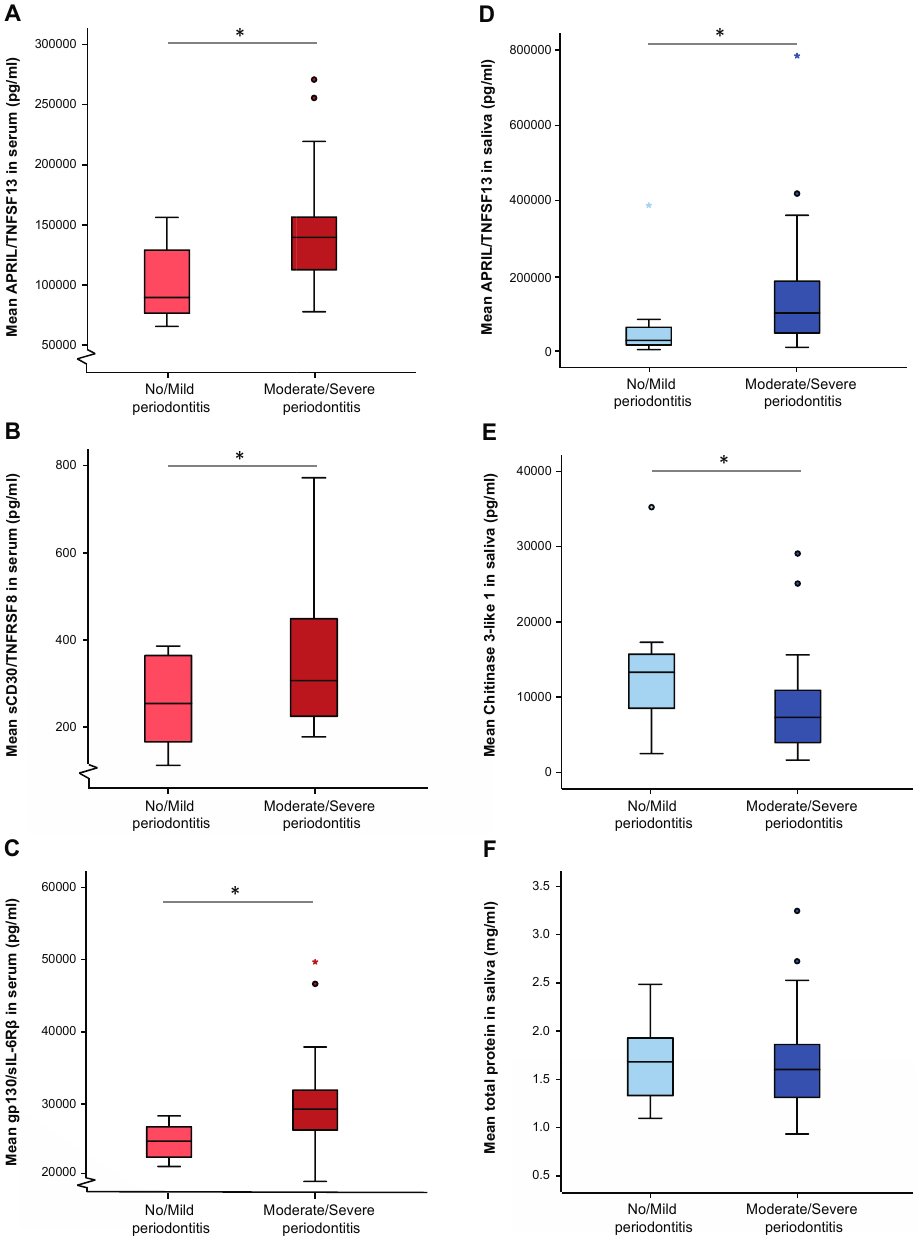
Figure 1. Levels of inflammatory mediators in serum and saliva samples. Mean (±SD) serum concentrations of APRIL/TNFSF13 ( A ), sCD30/TNFRSF8 ( B ) and gp130/sIL-6Rß ( C ); mean (±SD) saliva concentrations of APRIL/TNFSF13 ( D ), Chitinase 3-like 1 ( E ) and levels of total protein in saliva ( F ) from RA patients with no/mild and moderate/severe periodontitis. The differences between the groups were analysed by Mann–Whitney U-test. * p value < 0.05 was considered statistically significant. Circle indicates outlier and star indicates far outlier.